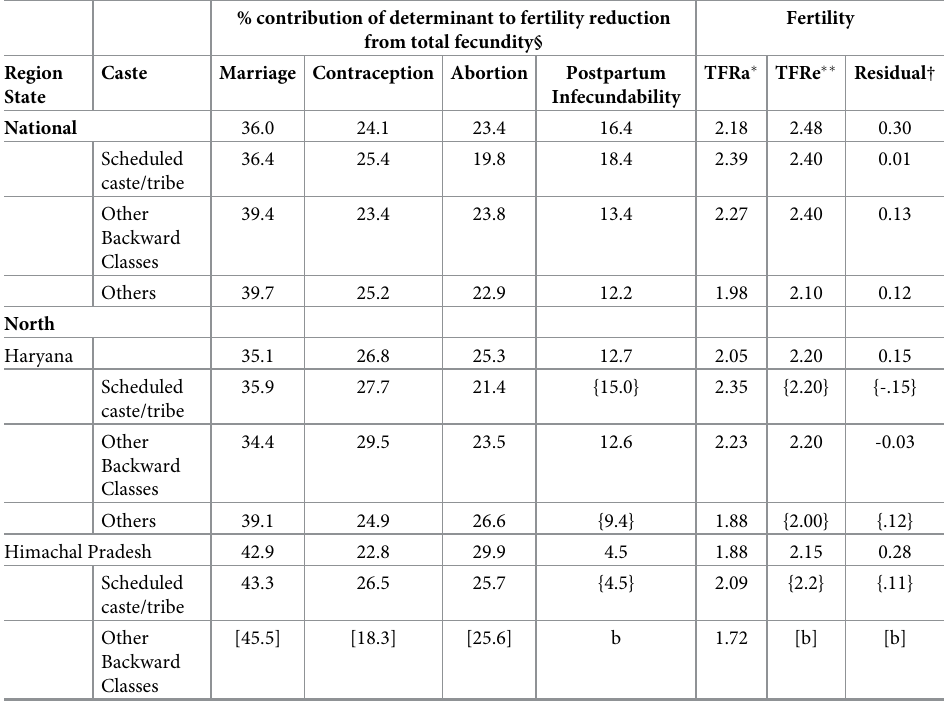
Table 6. Estimates of the percent contribution of four key proximate determinants to fertility reduction, actual TFR, estimated TFR and residual by caste: National and by state, India 2015–16. % contribution of determinant to fertility reduction from total